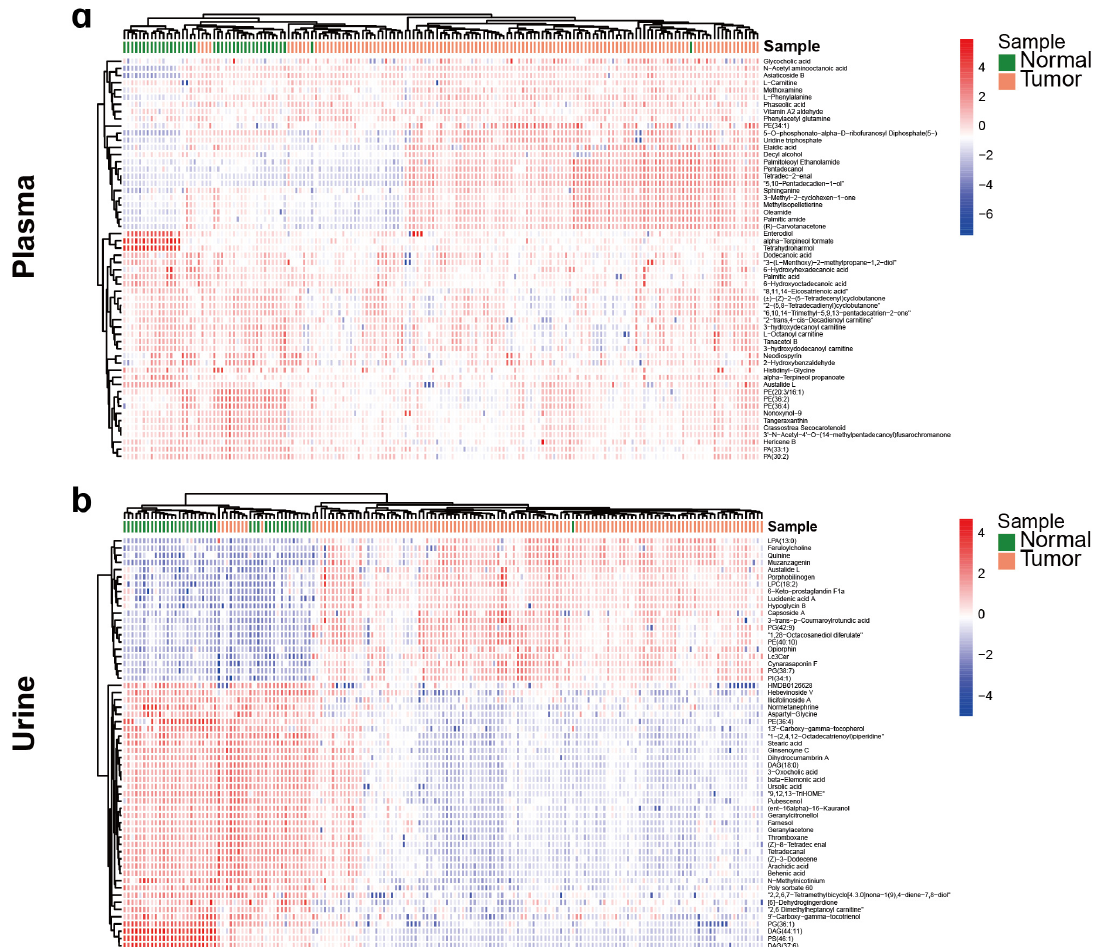
Figure 3. Heatmap of the differential putative metabolites from normal controls versus ovarian tumors. ( a ) Heatmap of the differential putative metabolites from normal control versus ovarian tumor in urine samples. ( b ) Heatmap of the differential putative metabolites from normal control versus ovarian tumor in plasma samples. Red color indicated higher level in ovarian tumor. Blue color indicated lower level in ovarian tumor.